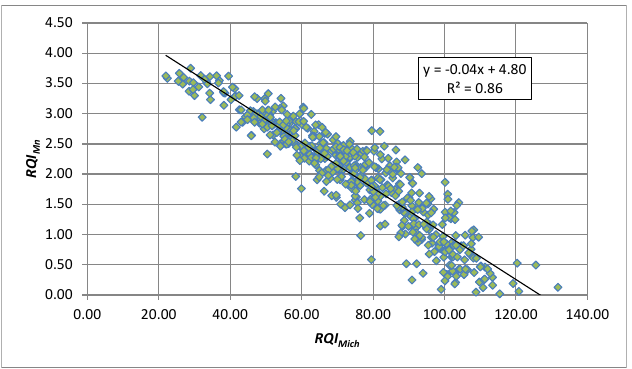
Figure 3. Correlation between RQI Mn and RN .